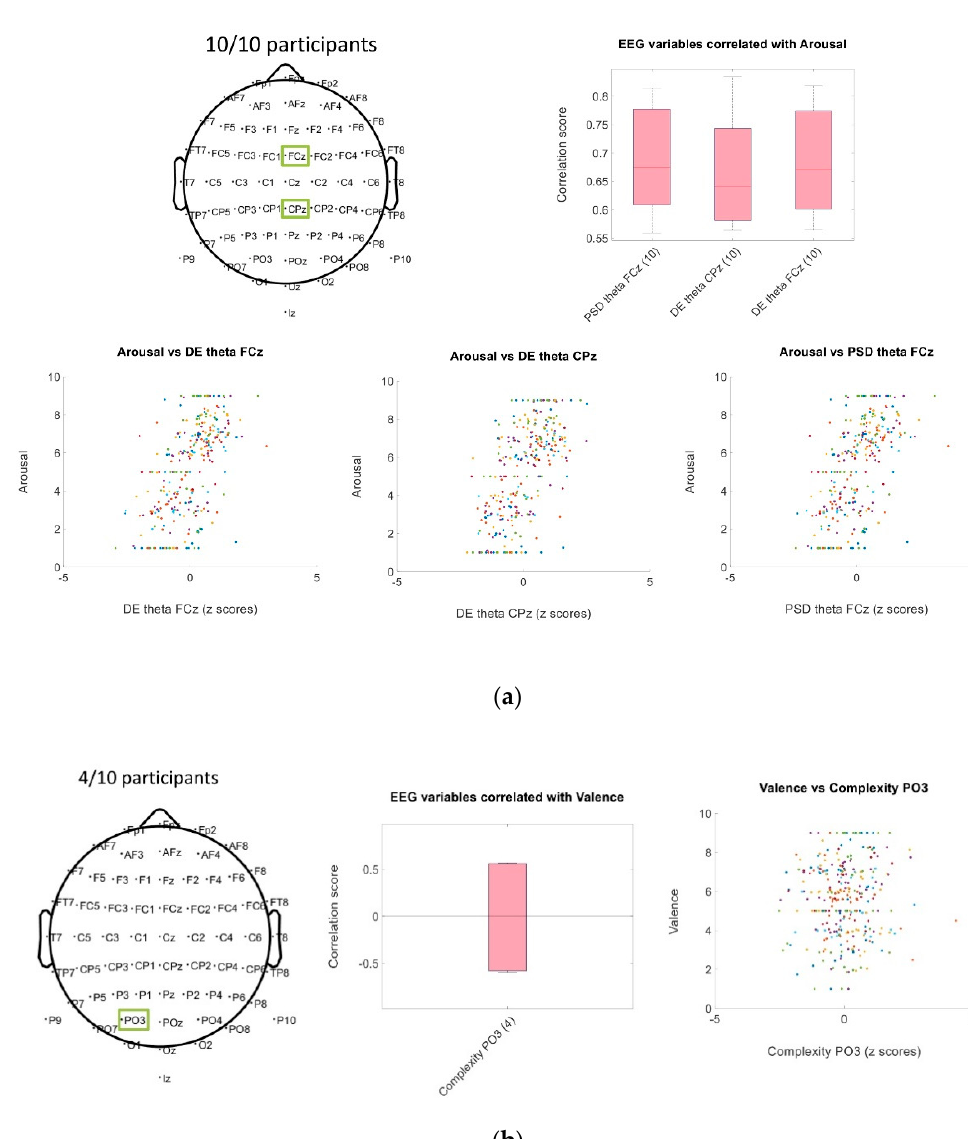
Figure 3. Spearman correlation score’s dispersion of traits common for the participants. ( a ) Traits correlated with arousal scores. The reported traits have positive rho scores with a mean value above 0.6. ( b ) Trait correlated with valence scores, for 4 participants only one trait had a strong correlation, in this case, the correlations had positive and negative rho scores among participant whit scores no higher than 0.6.